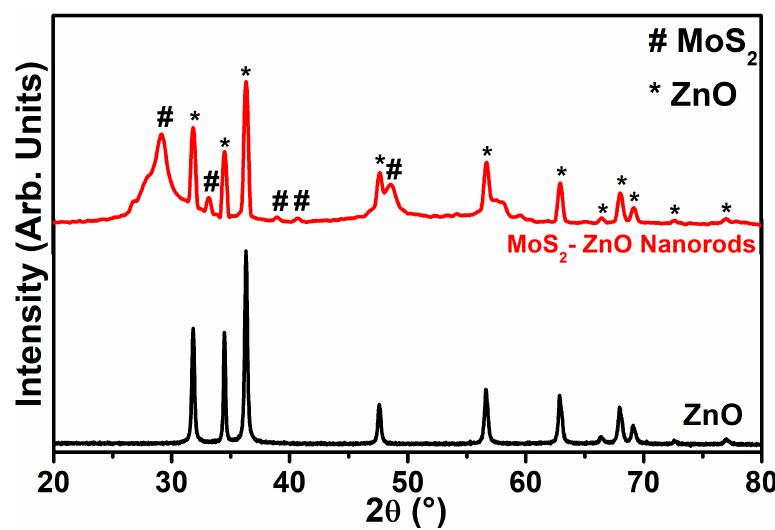
Figure 1. Typical XRD diffraction patterns of synthesized ZnO nanoparticles and MoS 2 -ZnO heterostructure nanorods.